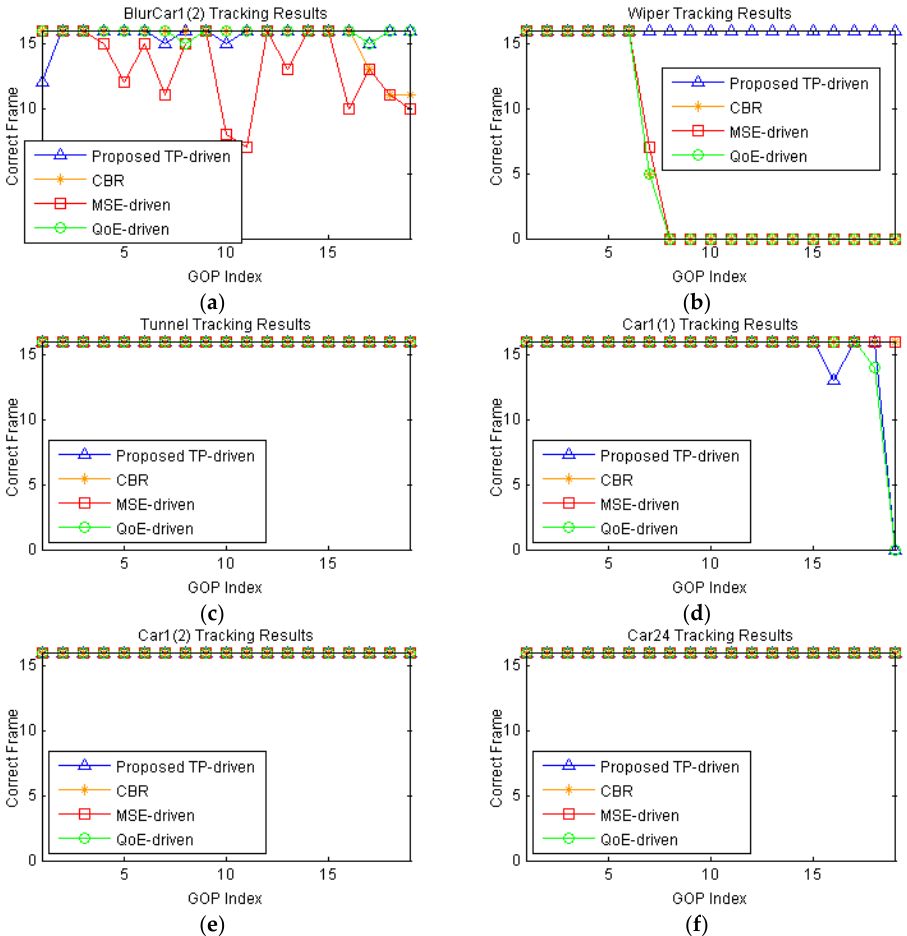
Figure 11. Tracking results of all GOPs in each video under 800 kb/s total rate constraint. The packet loss rate of each video is 1%: ( a ) BlurCar1(2); ( b ) Wiper; ( c ) Tunnel; ( d ) Car1(1); ( e ) Car1(2); ( f ) Car24.